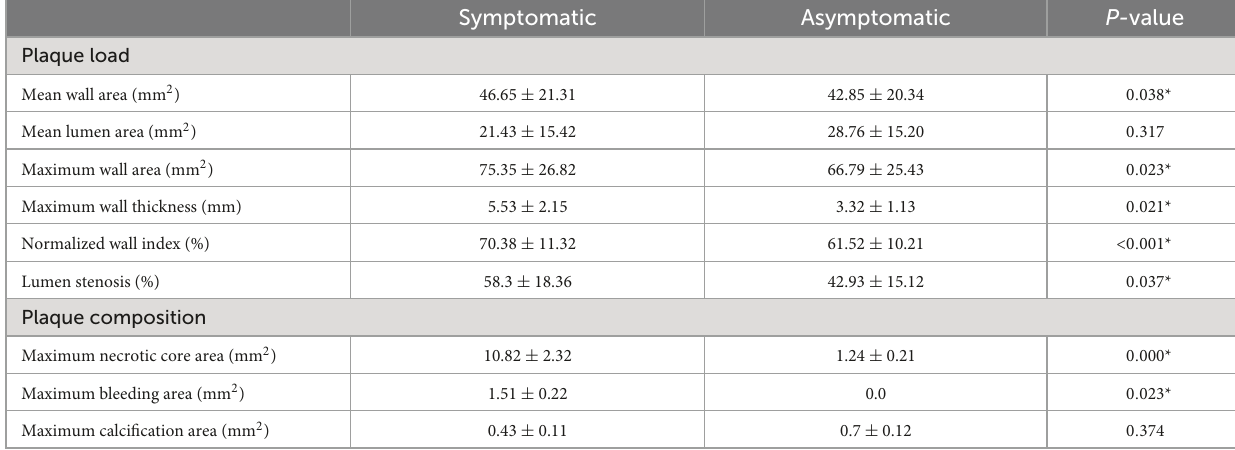
TABLE 4 Morphology of carotid atherosclerotic plaques on high resolution